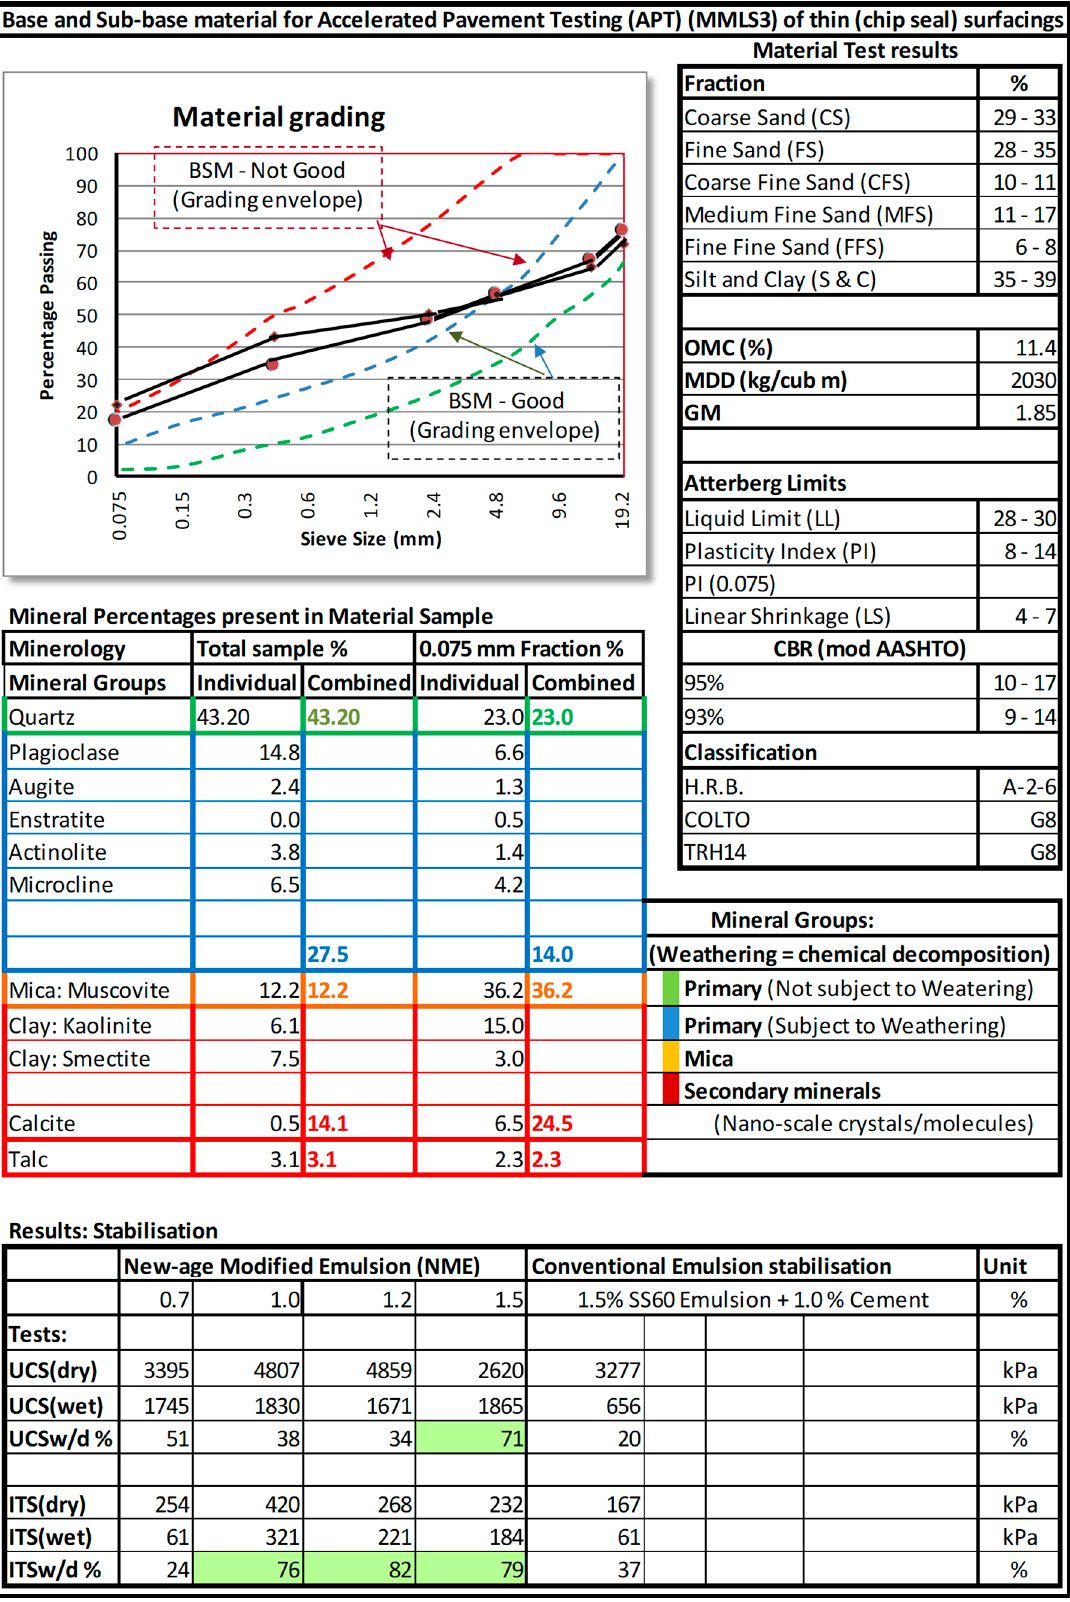
Figure 1. Material test results, mineralogy and new-age nano-modified emulsion (NME) stabilisation results of the base material. UCS, unconfined compressive strength; ITS, indirect tensile strength; BSM, bituminous stabilised materials .